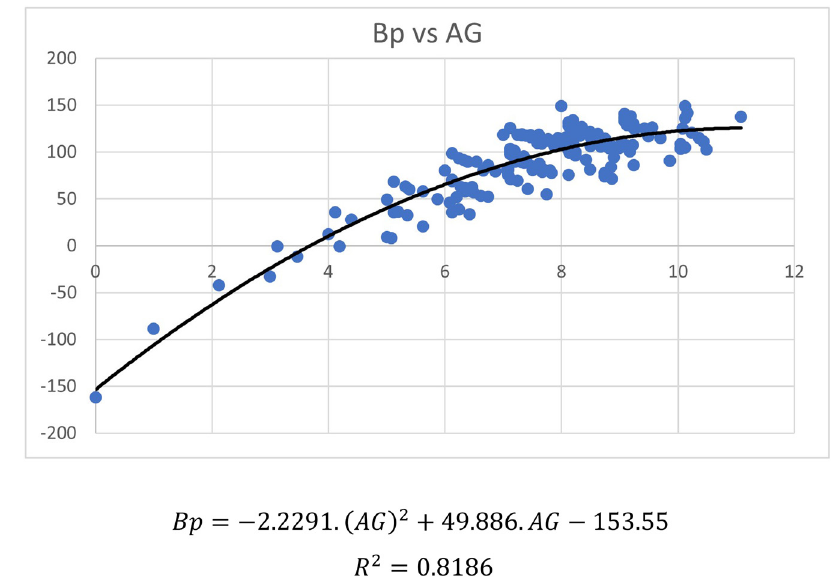
Figure 6: Quadratic regression Bp versus AG .